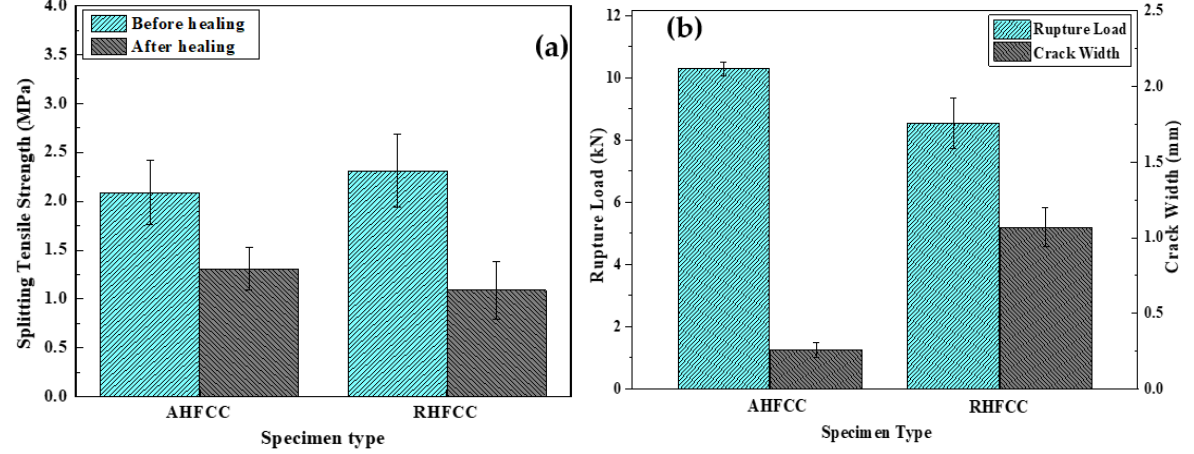
Figure 7. Healing capability evaluation: ( a ) splitting tensile strength before and after healing, ( b ) load – crack width relationship after healing.